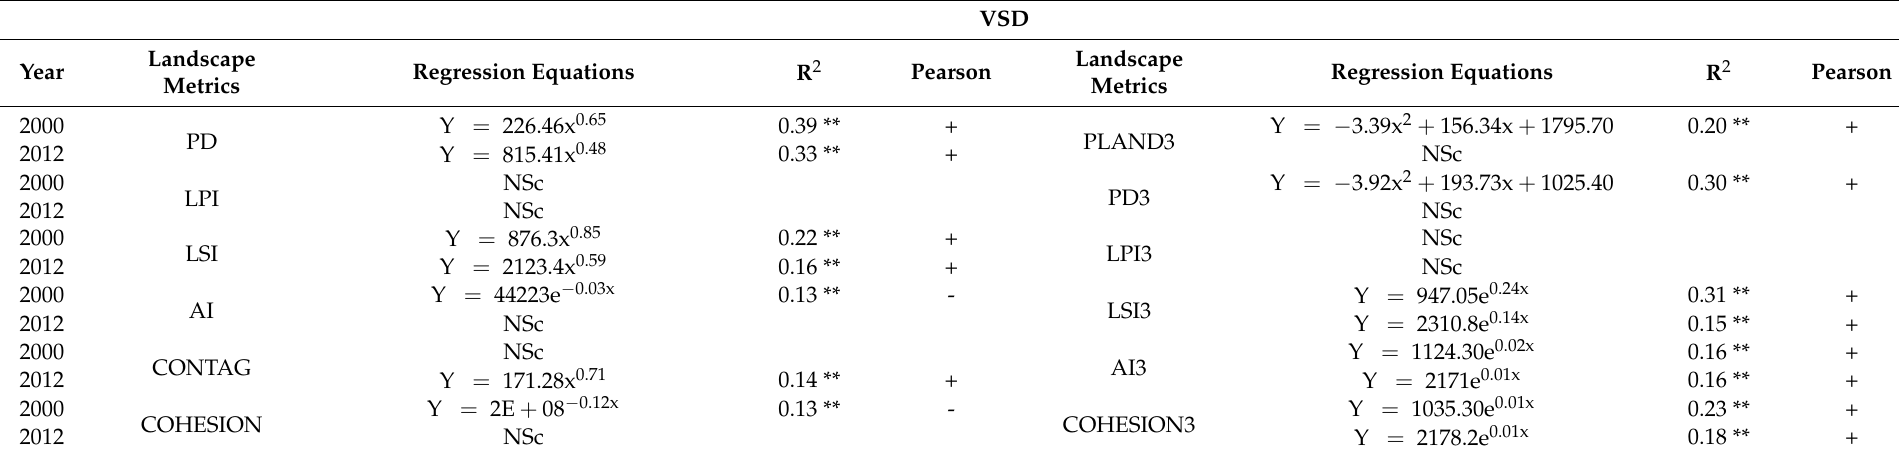
Table A2. Regression equations between landscape metrics and